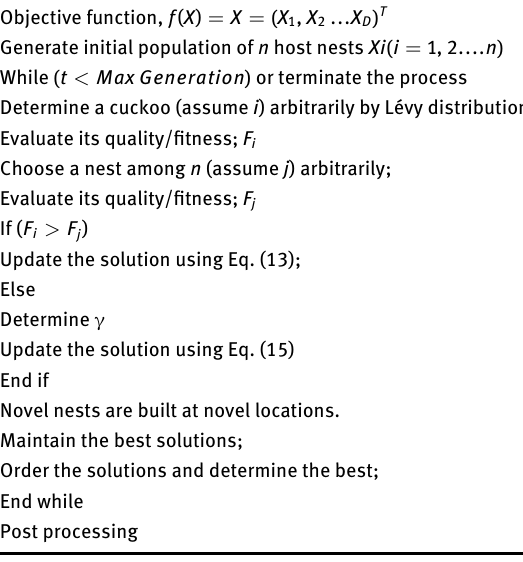
Algorithm 1: Pseudo code of